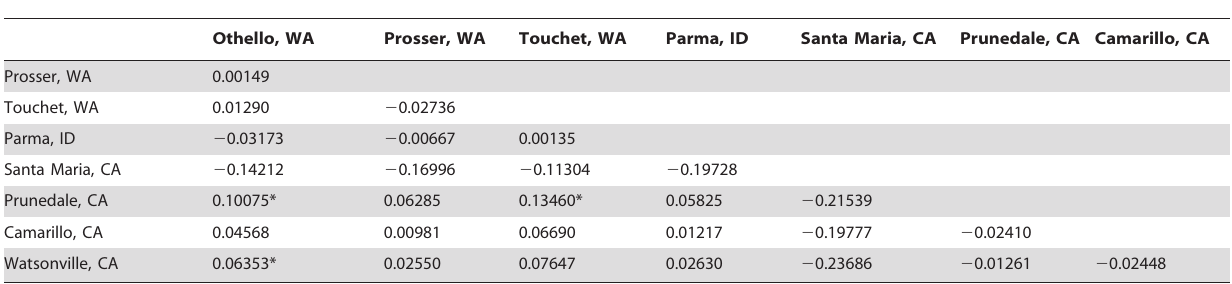
Table 5. Pairwise estimates of F st between L. hesperus populations from California, Washington, and Idaho, *P , 0.05, **P , 0.01.